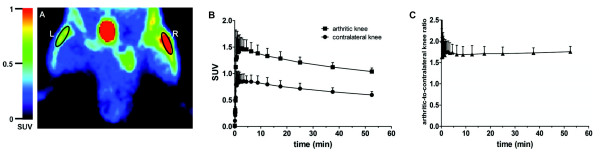
[18F]fluoro-PEG-folate images and corresponding time-activity curves of arthritic and normal knees. (A) Example of [18F]fluoro-PEG-folate image of arthritic rat at the level of the knees (L = left contralateral knee, R = right arthritic knee). (B) corresponding time-activity curves (of ROI as indicated in 4A) of arthritic and contralateral knees. (C) Arthritic-to-contralateral knee ratio as function of time. Results are presented as mean ± SD of four arthritic rats.